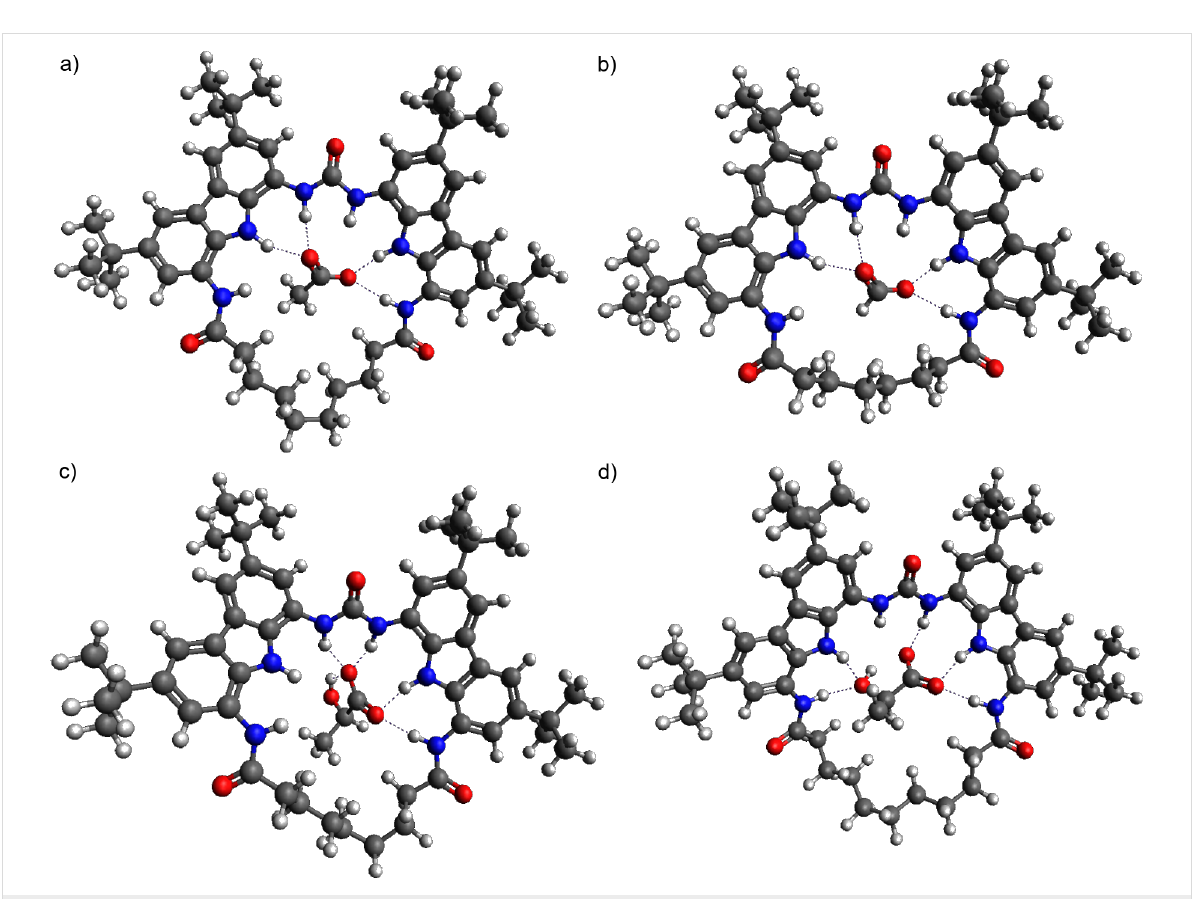
Figure 5: a) Complex of MC008 with acetate; b) complex of MC006 with formate; c) complex of MC007 with lactate showing an intramolecular hydro- gen bond; d) complex of MC009 with lactate showing an additional hydrogen bond with an amide NH of the macrocycle.